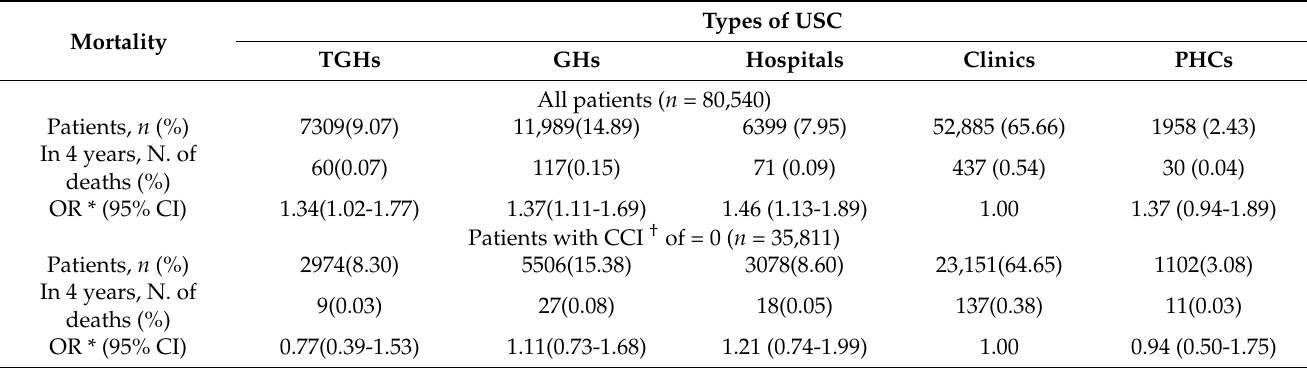
Table 3. All-cause Mortality by USC